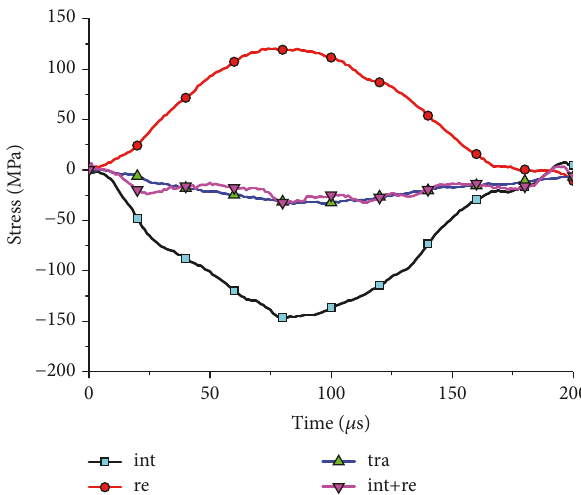
Figure 4: Stress equilibrium check for the dynamic compression tests of coal-rock combined